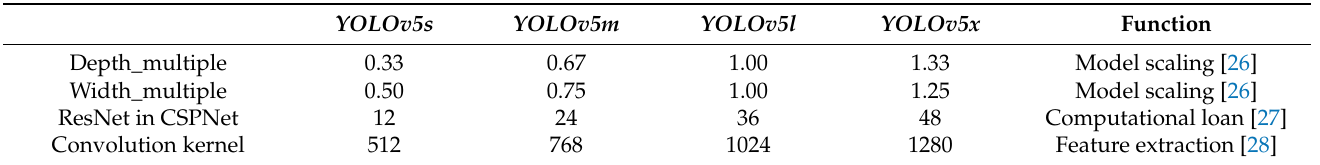
Table 1. The difference between YOLOv5 models.